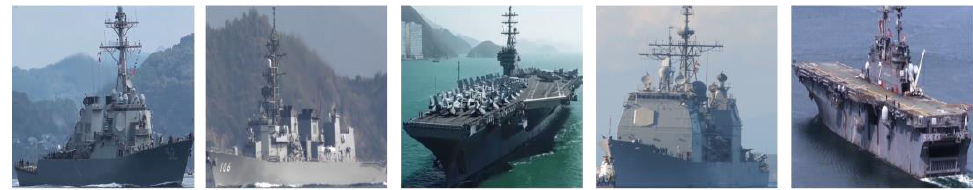
Figure 1. Real ship images.